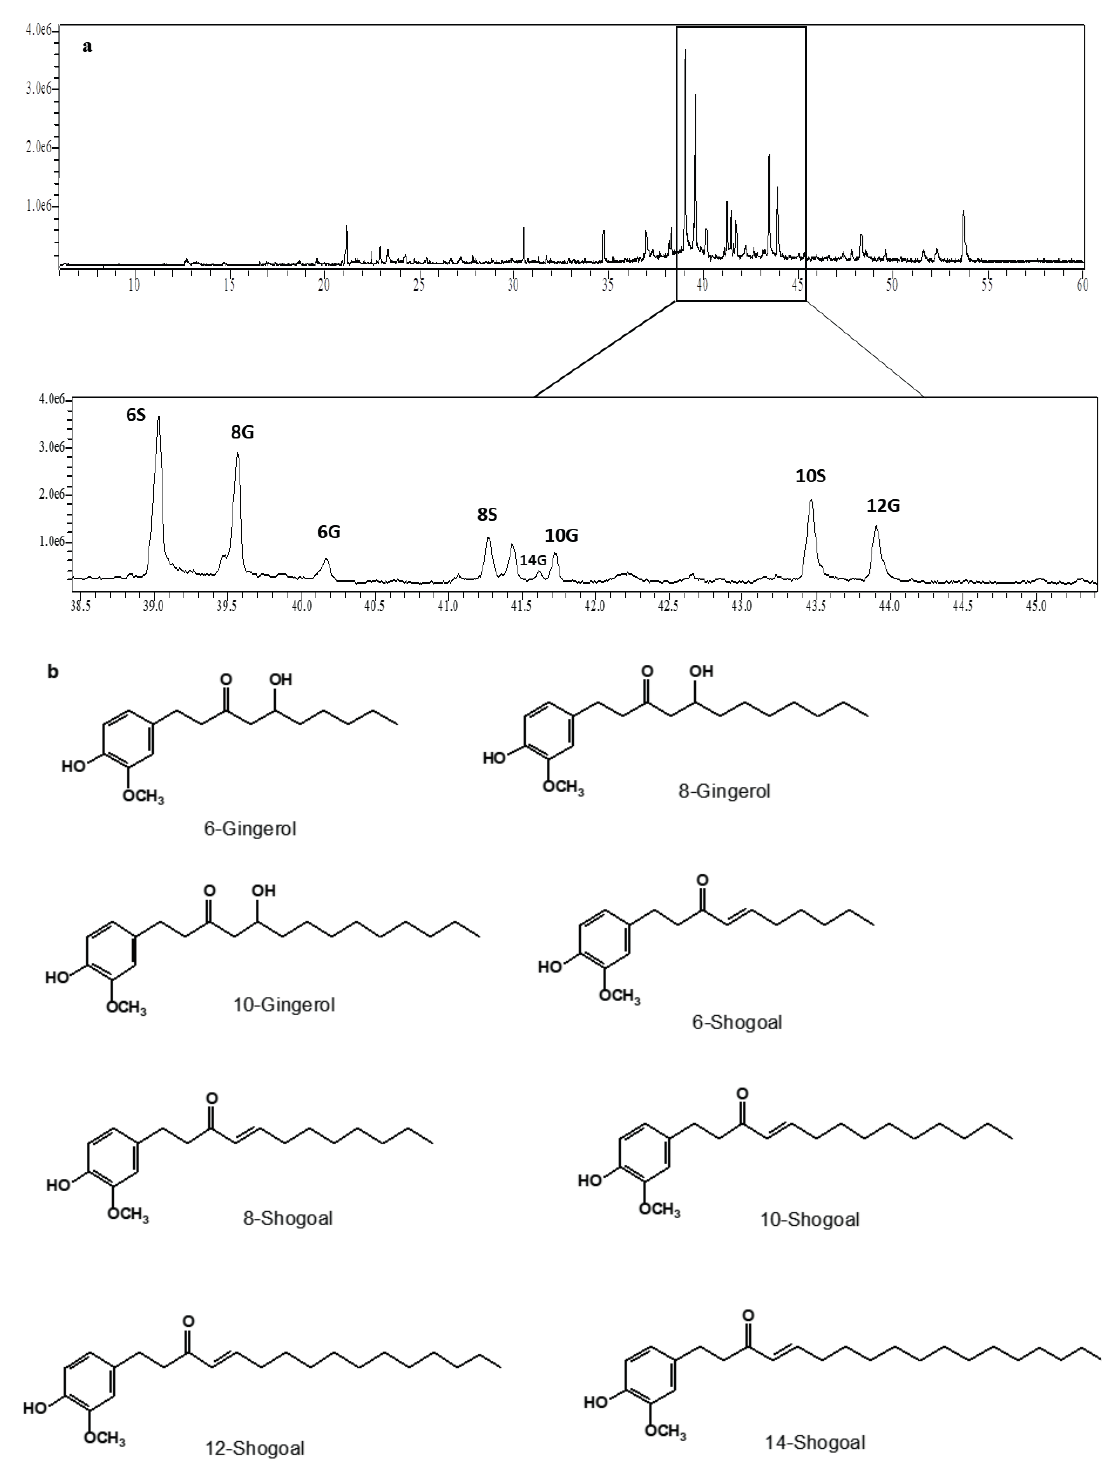
Figure 1 - a Chromatogram of the Zingiber officinale extract used in the study. 6S: 6-shogaol; 8G: 8-gingerol; 6G: 6-gingerol; 8S: 8-shogaol; 14G: 14-gingerol; 10G: 10-gingerol; 10S: 10-shogaol and 12G: 12-gingerol. b Chemical structure of the active compounds found in the